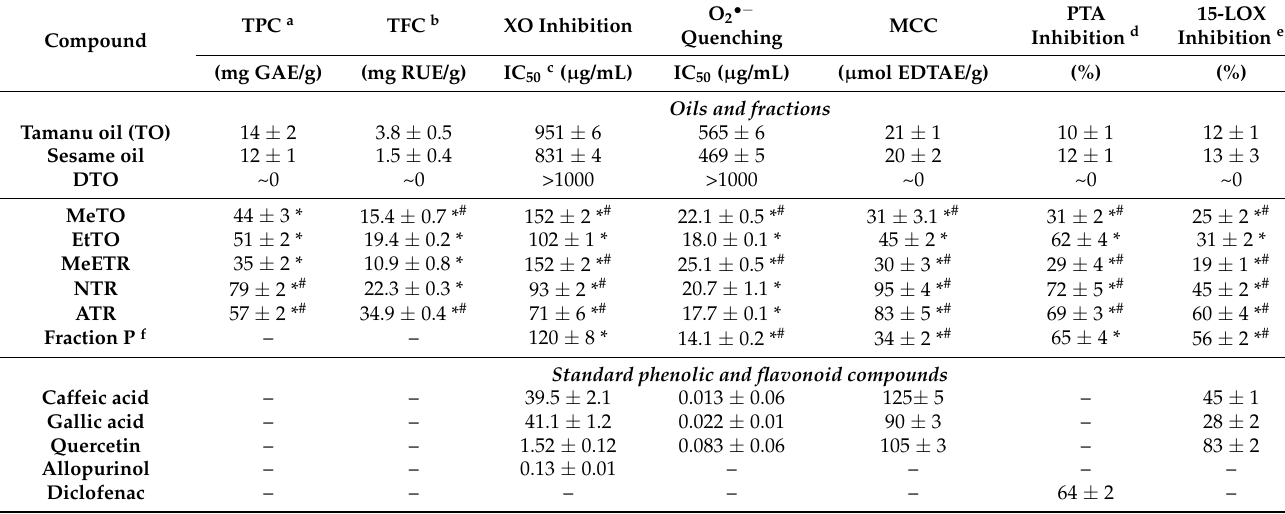
Data represent means ± SEM of 3–6 independent experiments performed in triplicate. a Values are expressed as mg of gallic acid equivalent (GAE) per gram of extract. b RUE, rutin equivalent. c IC 50 = concentration resulting in a 50% decrease in initial activity or concentration. d Percentage values are indicated for compounds at 150 µ g/mL. e Percent inhibition values are indicated for compounds at 100 µ g/mL. f Fraction P composition: inophyllum P (70%), tamanolide P (20%) and calanolide B (10%). Statistics: * p < 0.05 vs. TO and # p < 0.05 vs. EtTO, by one-way ANOVA followed by Newman-Keuls